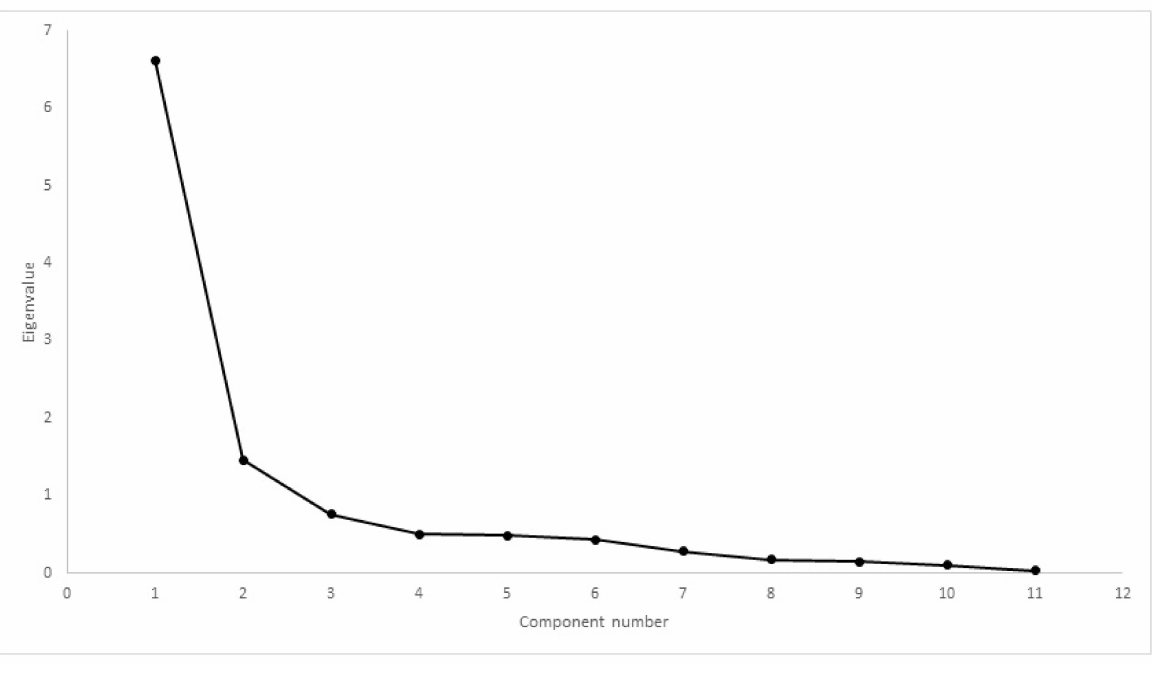
Figure 6. Scree plot of factor analysis of HVAS (Hudson Visual Analogue Scale). Two factors had eigenvalues >1, with a discernible “shoulder” observed.